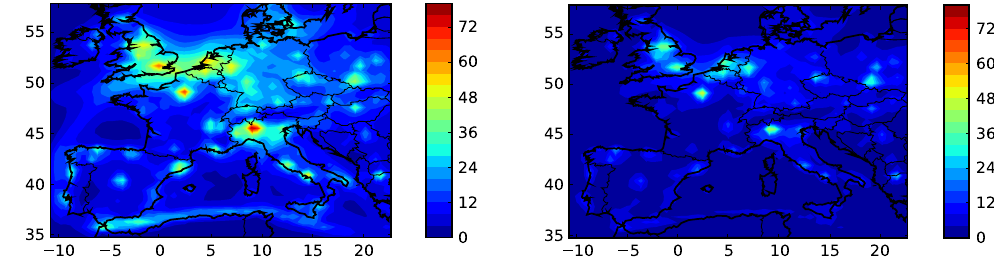
Fig. 9. Temporal average of NO 2 map for reference model 5 (left) and for model 90 of the 101-member ensemble (right).